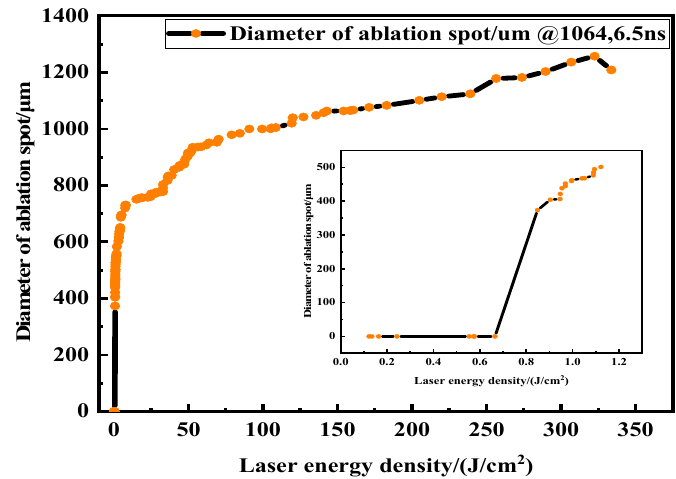
Figure 4. Curve of the damage area vs. laser fluence.